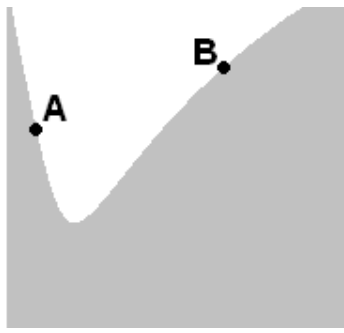
Figure 1. Example of a part of a non ‐ convex body.